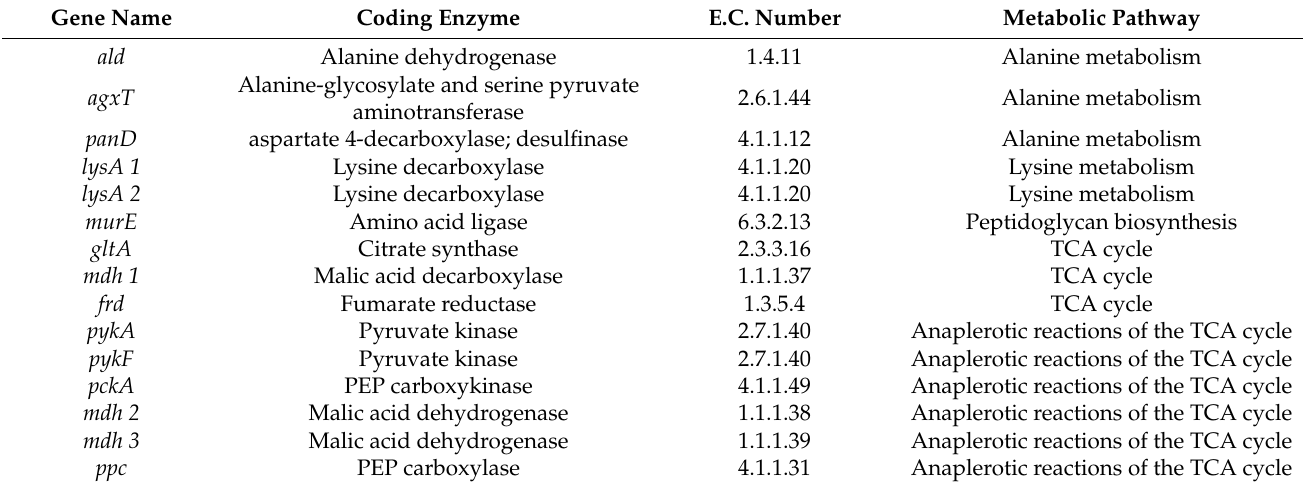
Table 5. Main metabolic genes and their corresponding coding enzymes that were studied in phage-susceptible and phage-resistant